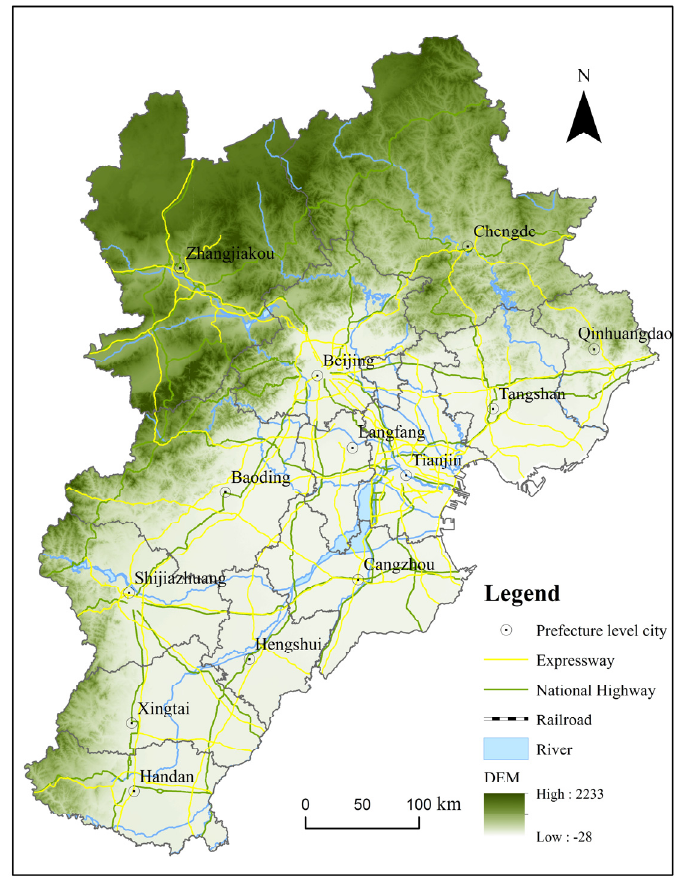
Figure 1. Map of Beijing–Tianjin–Hebei urban agglomeration.